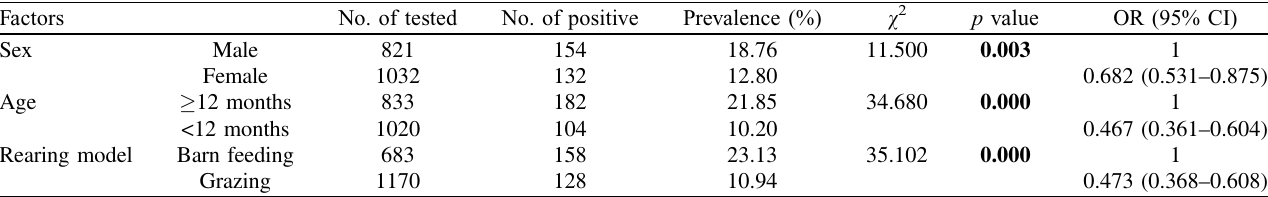
Grazing p values of statistically signi fi cant factors are highlighted in bold.